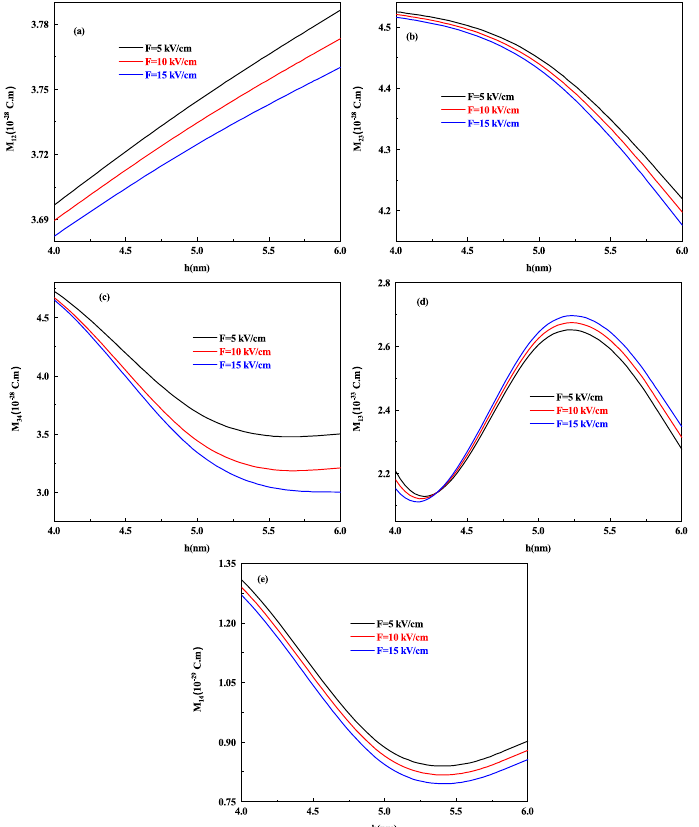
Figure 13. The DM elements ( a ) M 12 , ( b ) M 23 , ( c ) M 34 , ( d ) M 31 , and ( e ) M 41 as a function of oblate QD height h with R = 7 nm for different values of the perpendicular electric field F = 5, 10 and 15 kV/cm